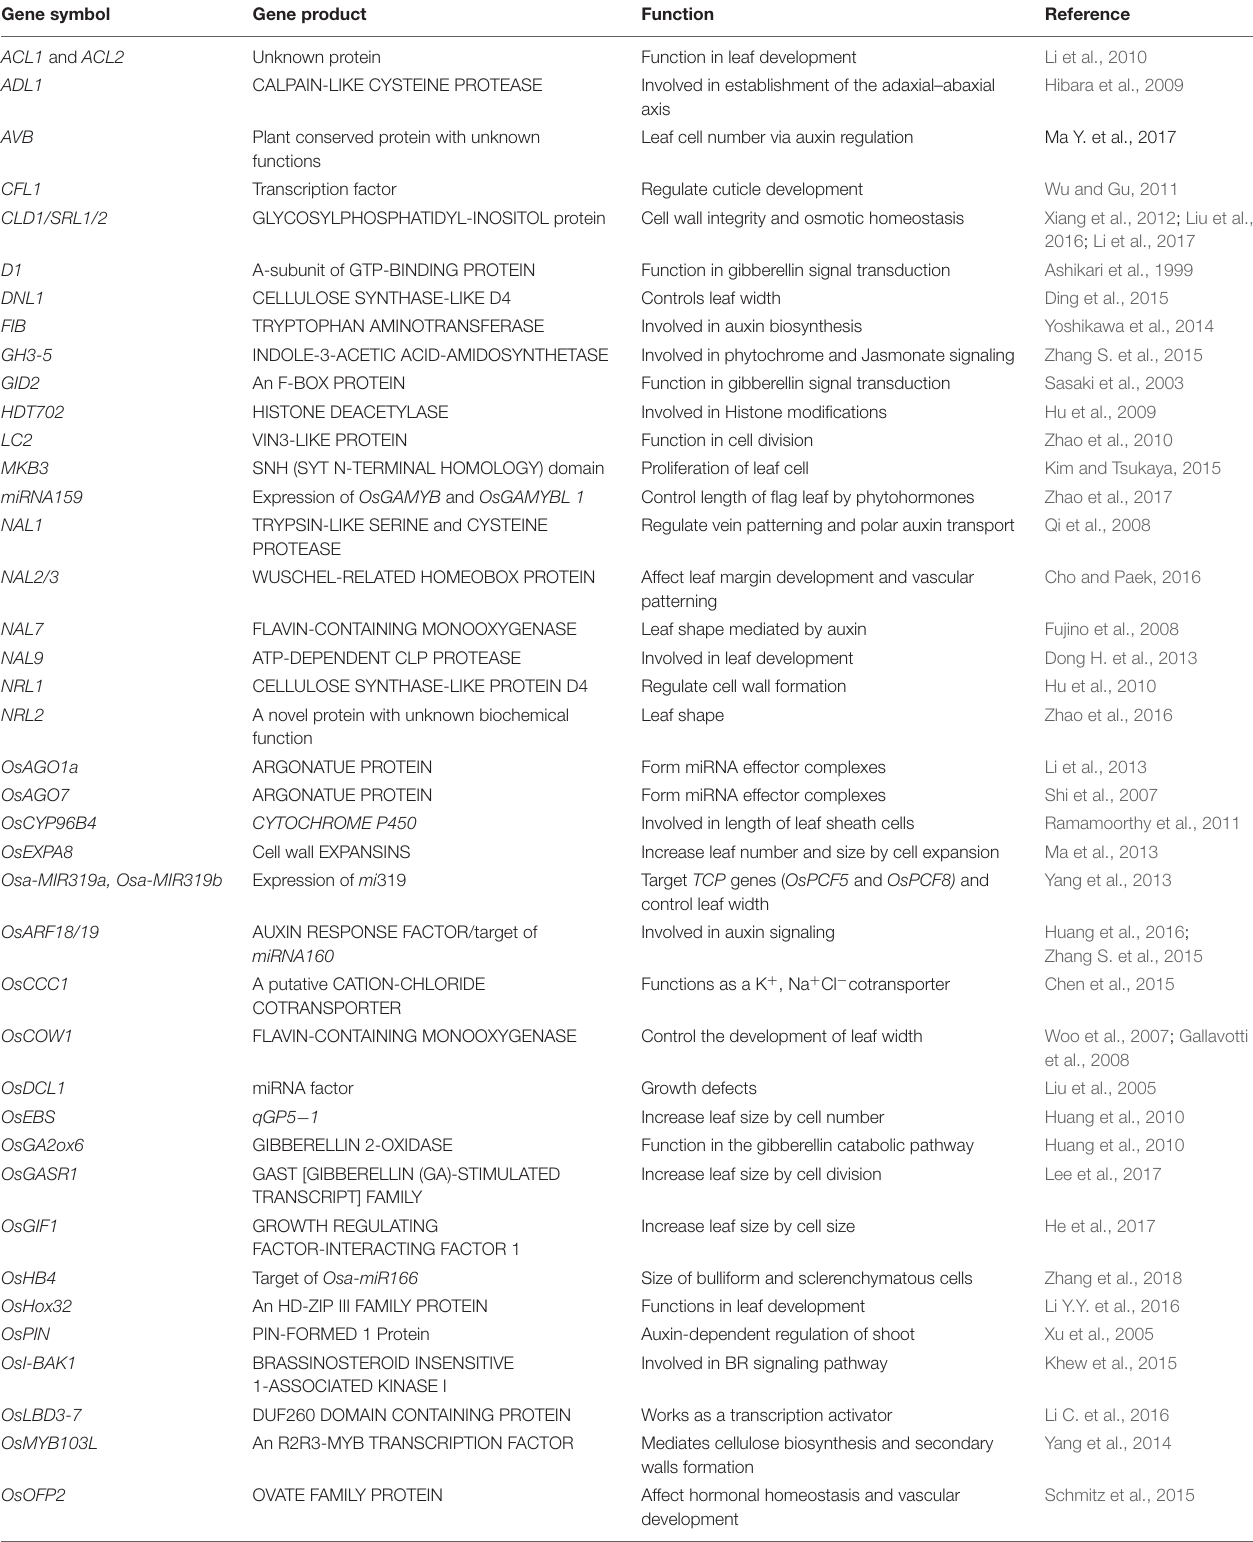
TABLE 1 | List of rice genes controlling leaf rolling and